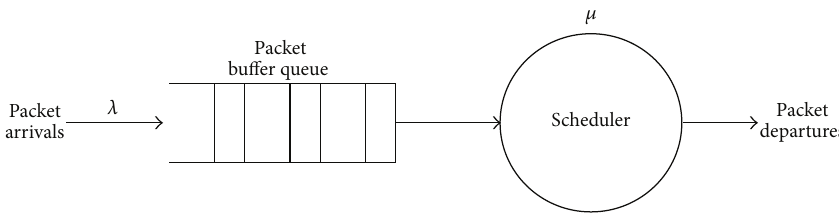
Figure 2: Data processing model for the queuing system without priority.